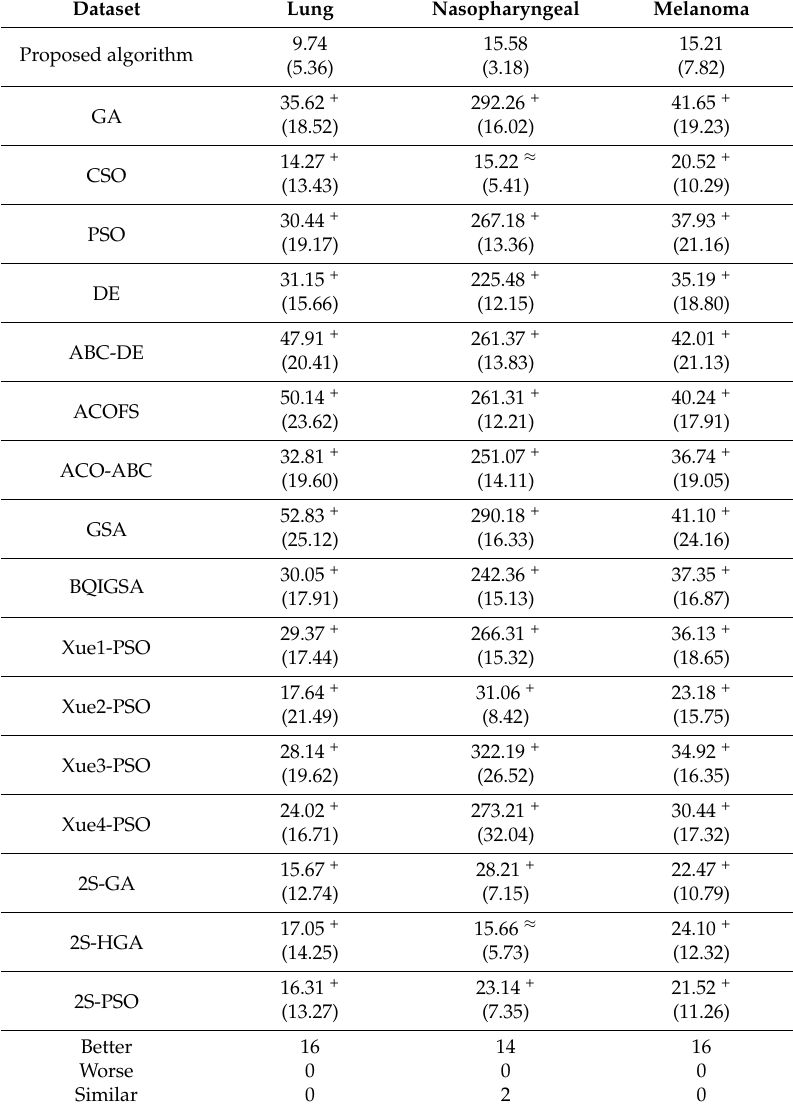
Table 4. Average number of selected miRNAs by different